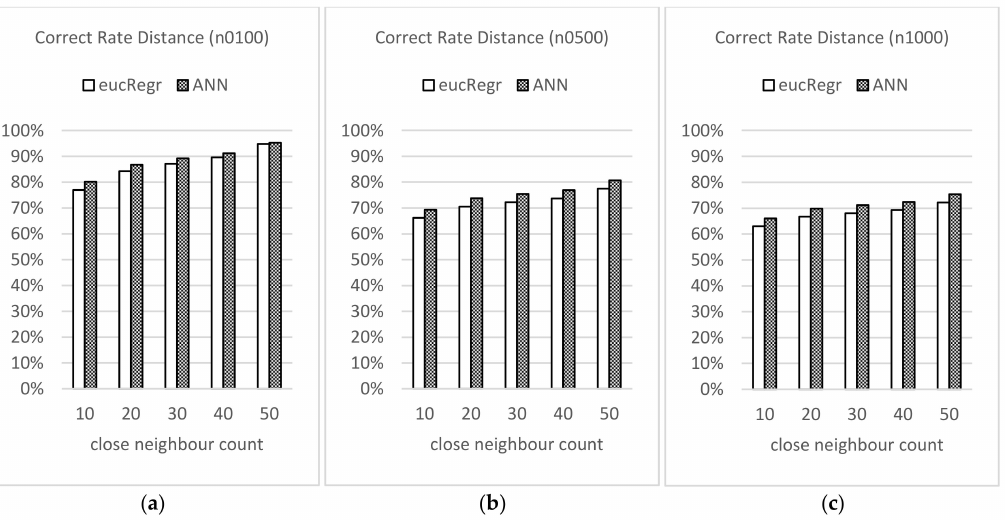
Figure 8. Correctness rate of selecting closest neighbors using estimated distance. ( a ) Number of nodes = 100. ( b ) Number of nodes. = 500. ( c ) Number of nodes = 1000.